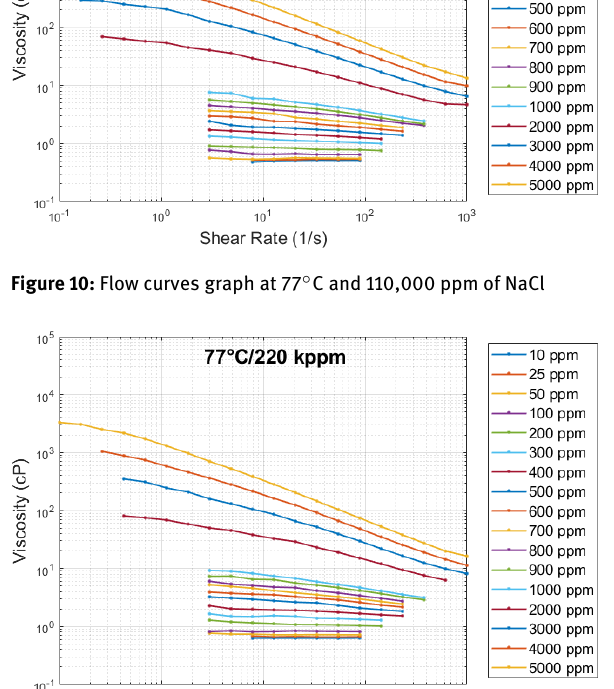
– 10 ppm concentration (Table 2). The critical concentra- tion increases sharply from the 23 ∘ C/ 20,000 ppm data and all the flow curves fall within the diluted region below the 2,000 ppm.